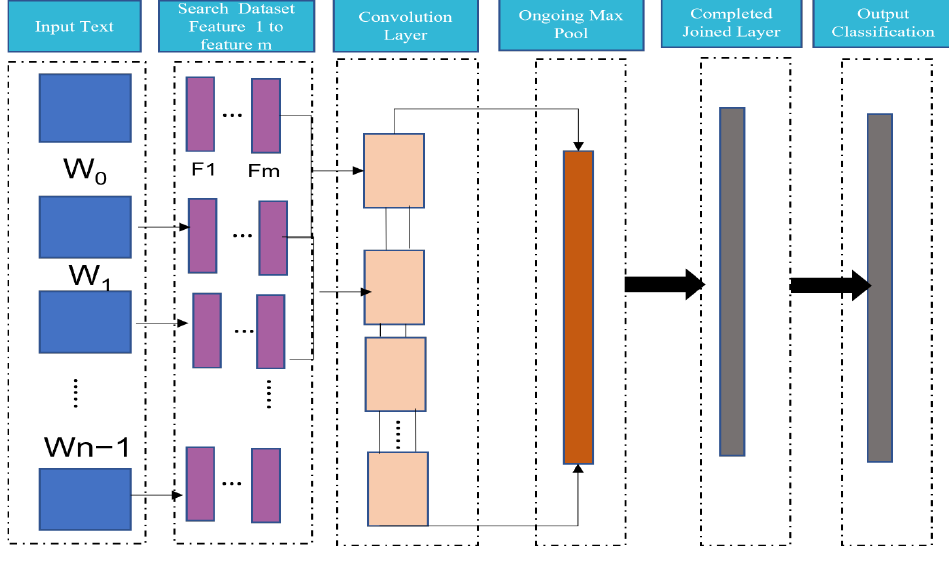
Figure 5. CNN architecture of NLP [14].